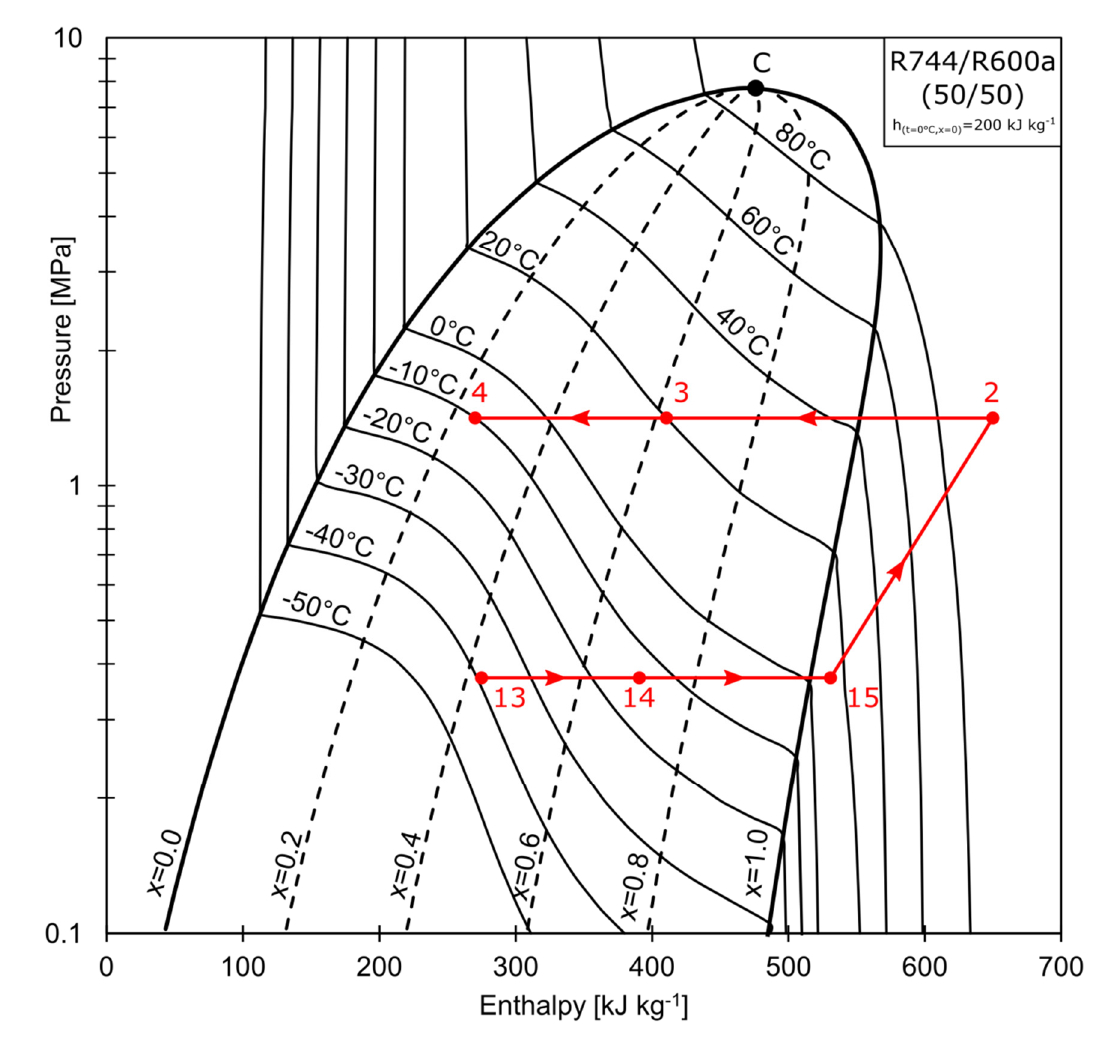
Figure 2. Pressure-enthalpy graph of ACR.